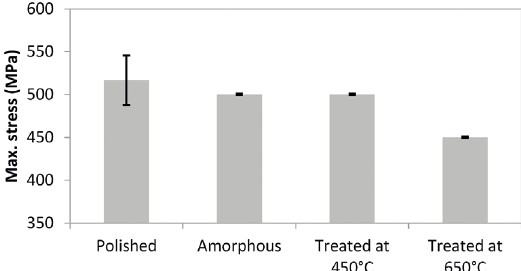
Figure 5. Summary of the fatigue results obtained with the stepwise load increase